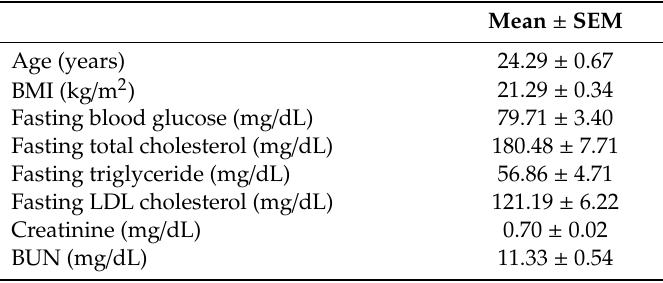
Table 2. Participant